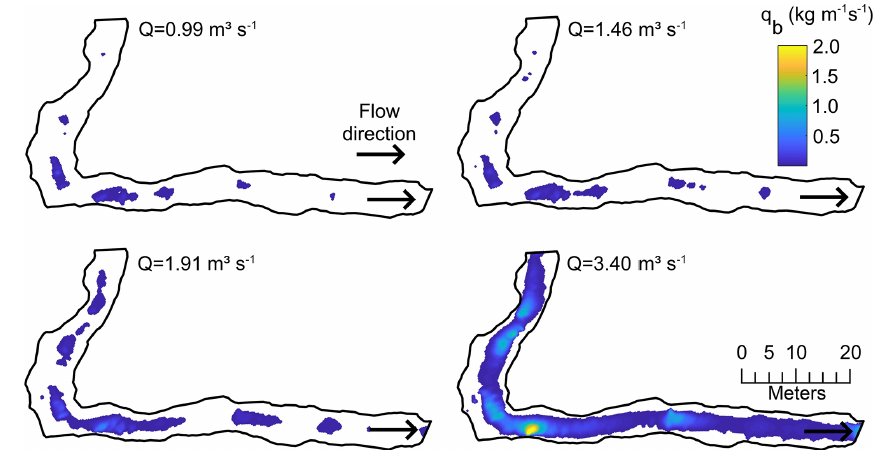
Figure 8. Predicted local bed load transport rate per unit width ( q b ) for four flows levels between 0.29 and 1.00 Q bf . White areas in each case indicate zero predicted transport. Black lines correspond to the wetted area under bankfull flow conditions. Maps of the predicted local shear stress for the same study area and flow scenarios are available in Katz et al. (2018).